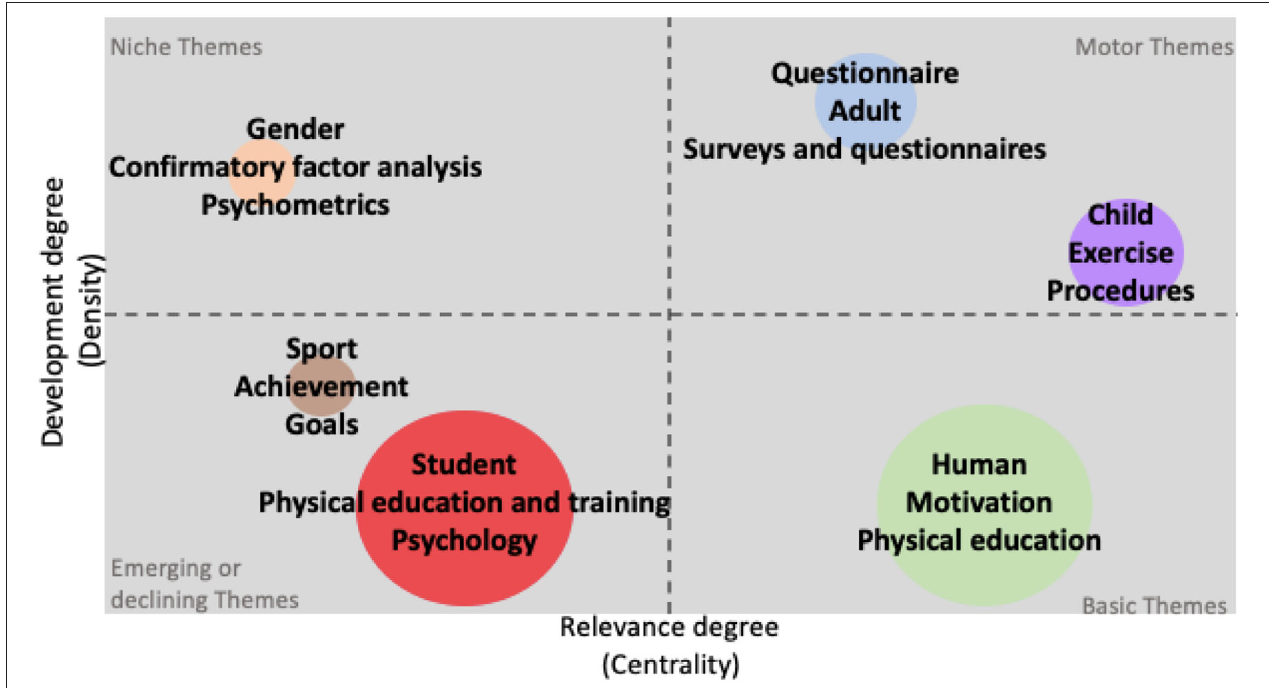
FIGURE 9 | Strategic